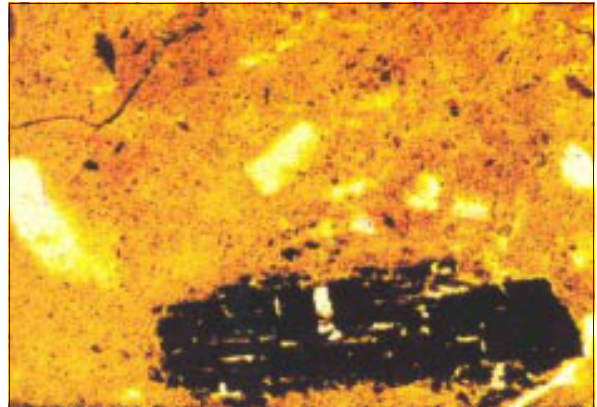
Figura 8. Fotomicrografia de um fragmento de carvão se decompondo, resultando em material plásmico Bruno a Bruno Avermelhado Escuro.